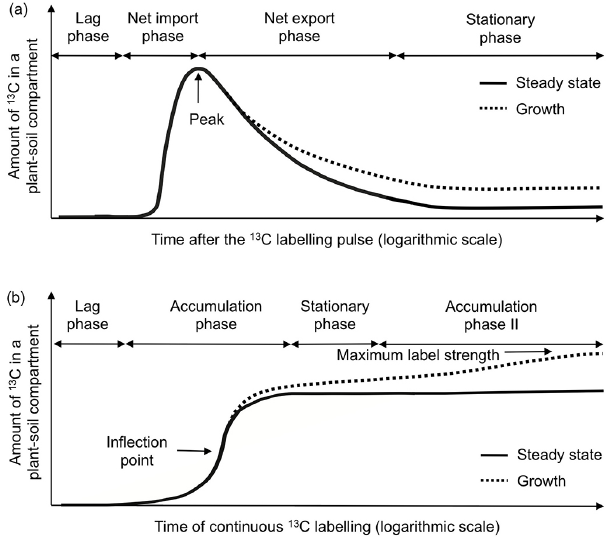
Fig. 1. Visualisation of the 13 C dynamics expected in plant-soil compartments after pulse labelling (a) or during continuous la- belling (b) given for a system at steady state or at growth (change in pool size). The short-term dynamics can be described by three phases: (1) lag phase (time needed for C transfer), (2) phase domi- nated by 13 C import or net accumulation and (3) phase dominated by 13 C export or stationary phase (equilibrium between 13 C import and export). On the long-term a forth phase can be identified, which is characterized by stationary (pulse labelling) or increasing (conti- nous labelling) 13 C